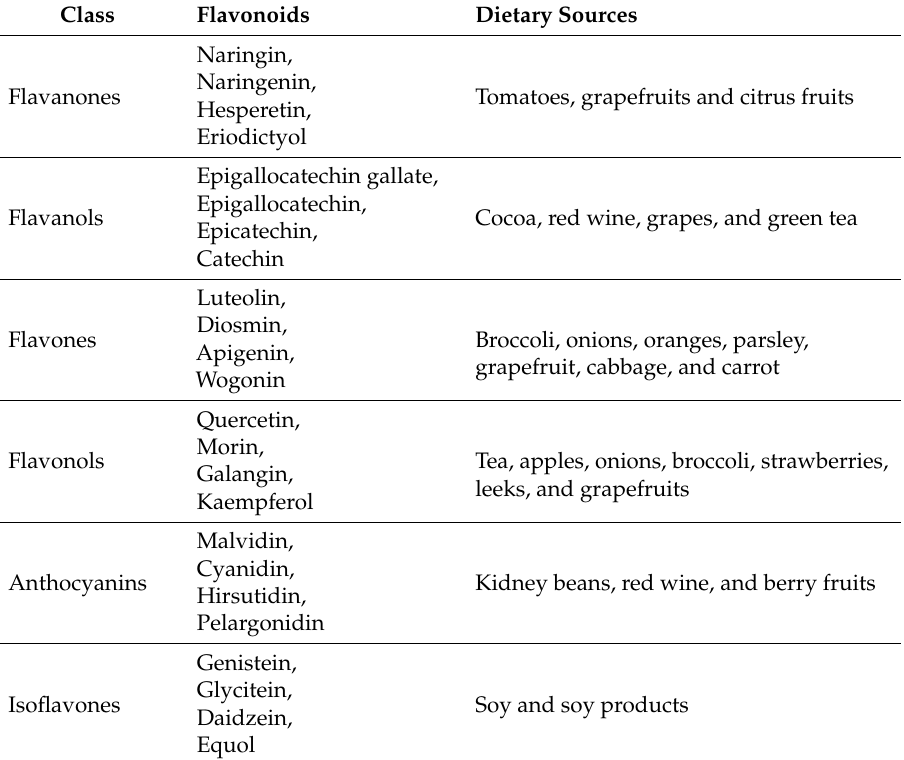
Table 1. Classification of flavonoids and their dietary